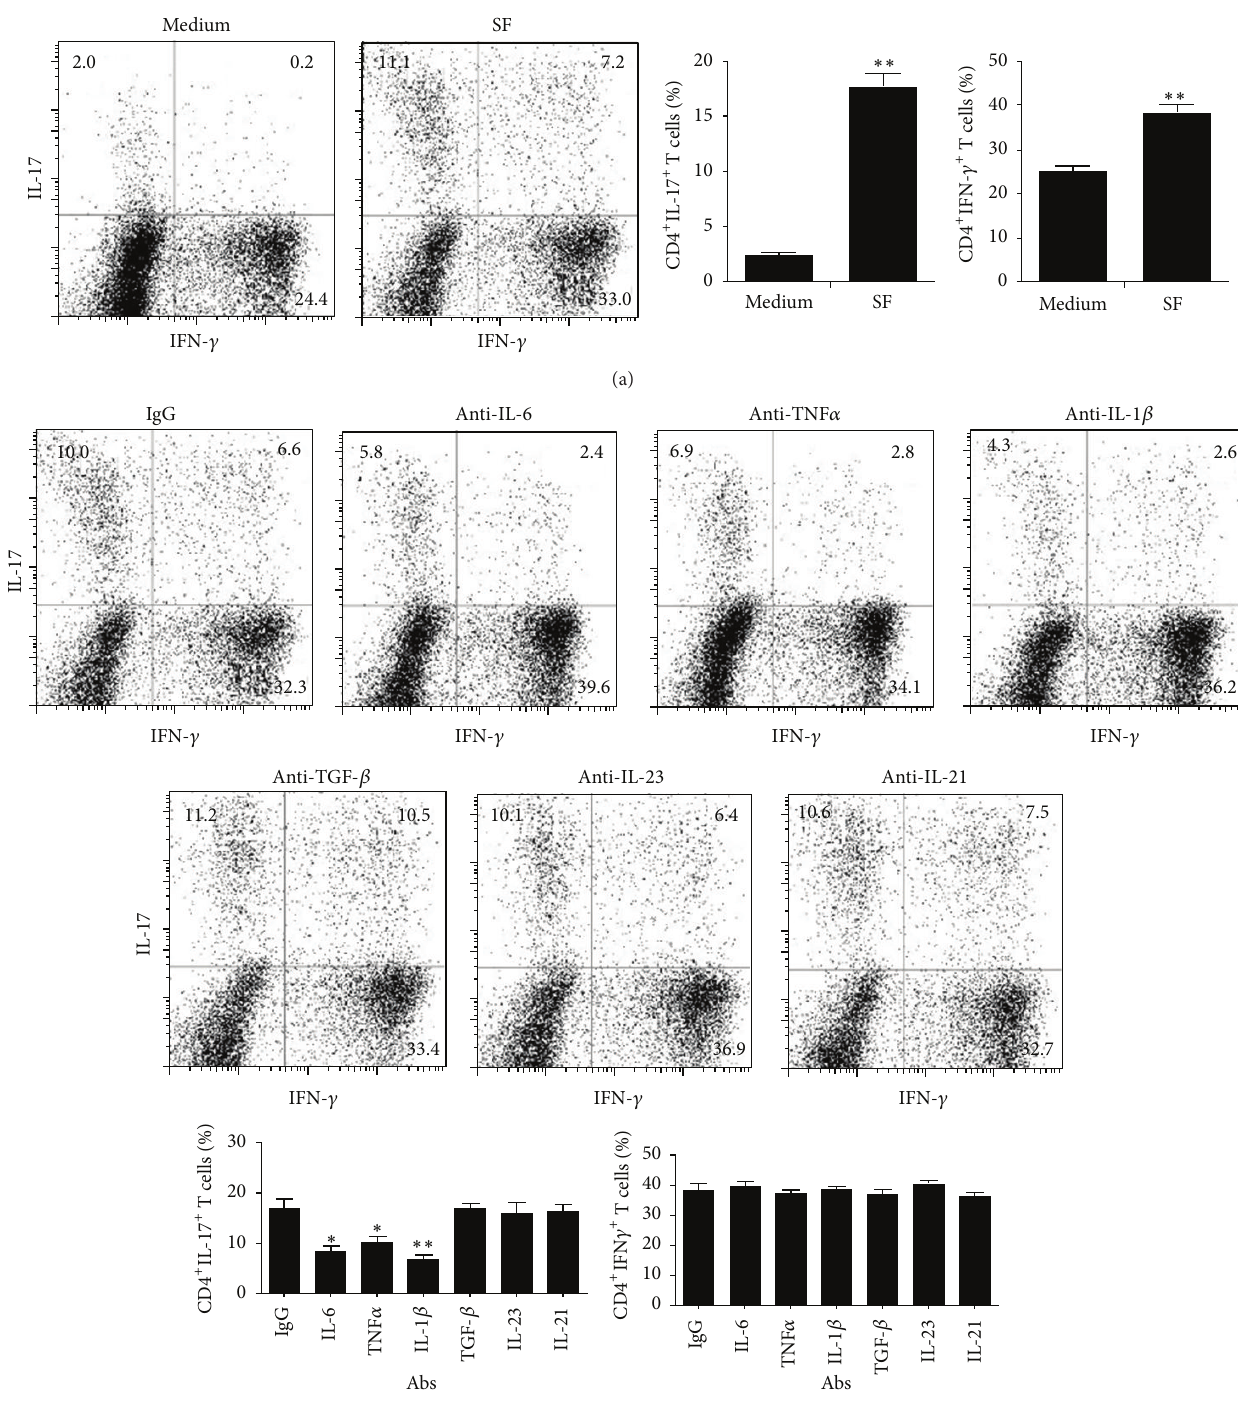
Figure 2: Enhanced Th17 cell differentiation by IL-6, IL-1 𝛽 , and TNF 𝛼 in synovial fluid. (a) PBMC preparations from healthy individuals were stimulated with anti-CD3/CD28 antibodies in the presence of the RA SF at dilution of 1: 8 and intracellular staining of IFN- 𝛾 and IL-17 was detected using flow cytometry. Data are representative of at least five separated experiments (left panel) and bars show the mean ± SEM (right panel). ∗∗ 𝑃 < 0.01 , versus medium control. (b) PBMC preparations from healthy individuals were stimulated with anti-CD3/CD28 antibodies for 96h, in the presence of RA SF pretreated with indicated antibodies. Percentage of Th1 and Th17 cells was analyzed. Data are representative of at least five separated experiments (upper and middle panels) and bars show the mean ± SEM (lower panel). ∗ 𝑃 < 0.05 and ∗∗ 𝑃 < 0.01 versus IgG